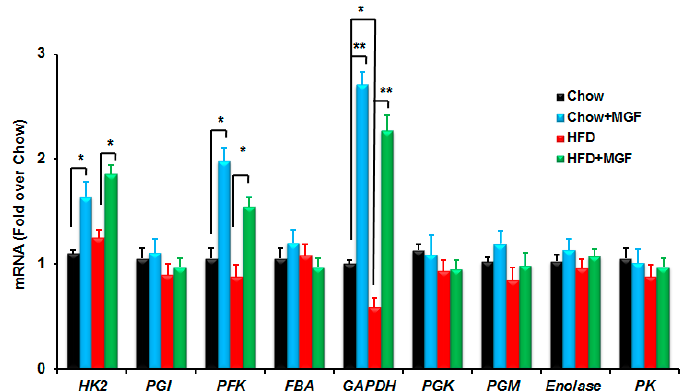
Figure 2. MGF induces mRNAs of some enzymes participating in glycolysis. Profiles of mRNAs of glycolytic enzymes in quadriceps from mice treated with chow or HFD ± MGF for 16 weeks. Values are average ± SEM ( n = 6/group). * p < 0.05, ** p < 0.01.